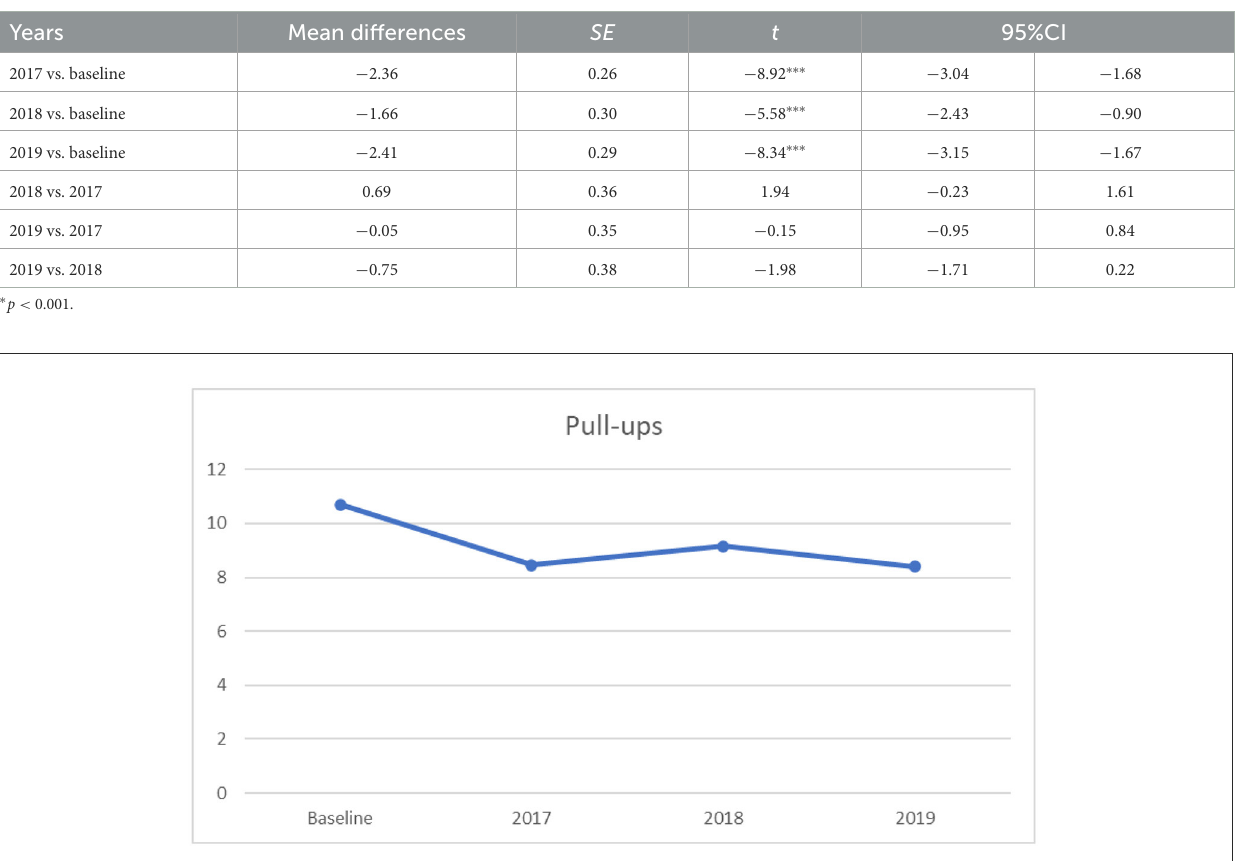
TABLE 8 Multiple comparisons: mean differences and confidence intervals for pull-ups across mean baseline (2013–2016), 2017, 2018, and 2019.